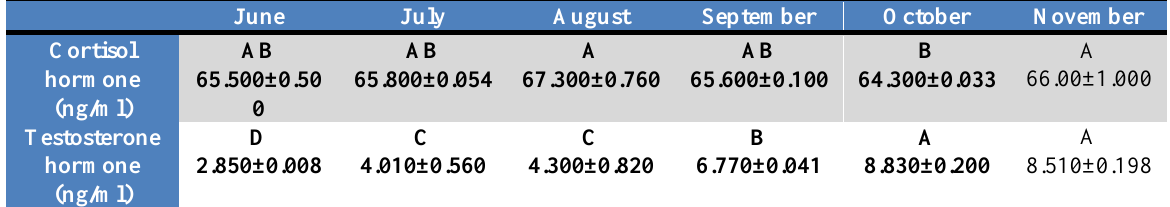
Table (2): Effects of heat stress on the cortisol hormone (ng/ml) and testosterone hormone (ng/ml) during study months